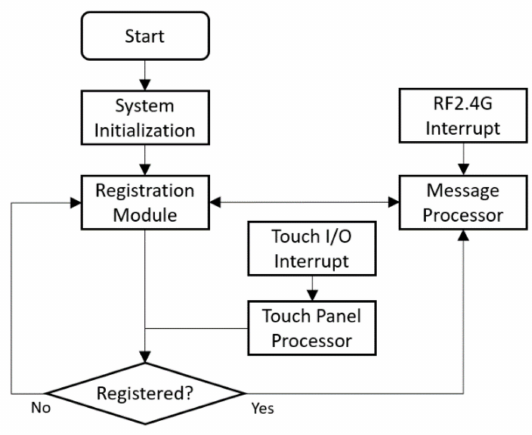
Figure 11. Software flowchart of control